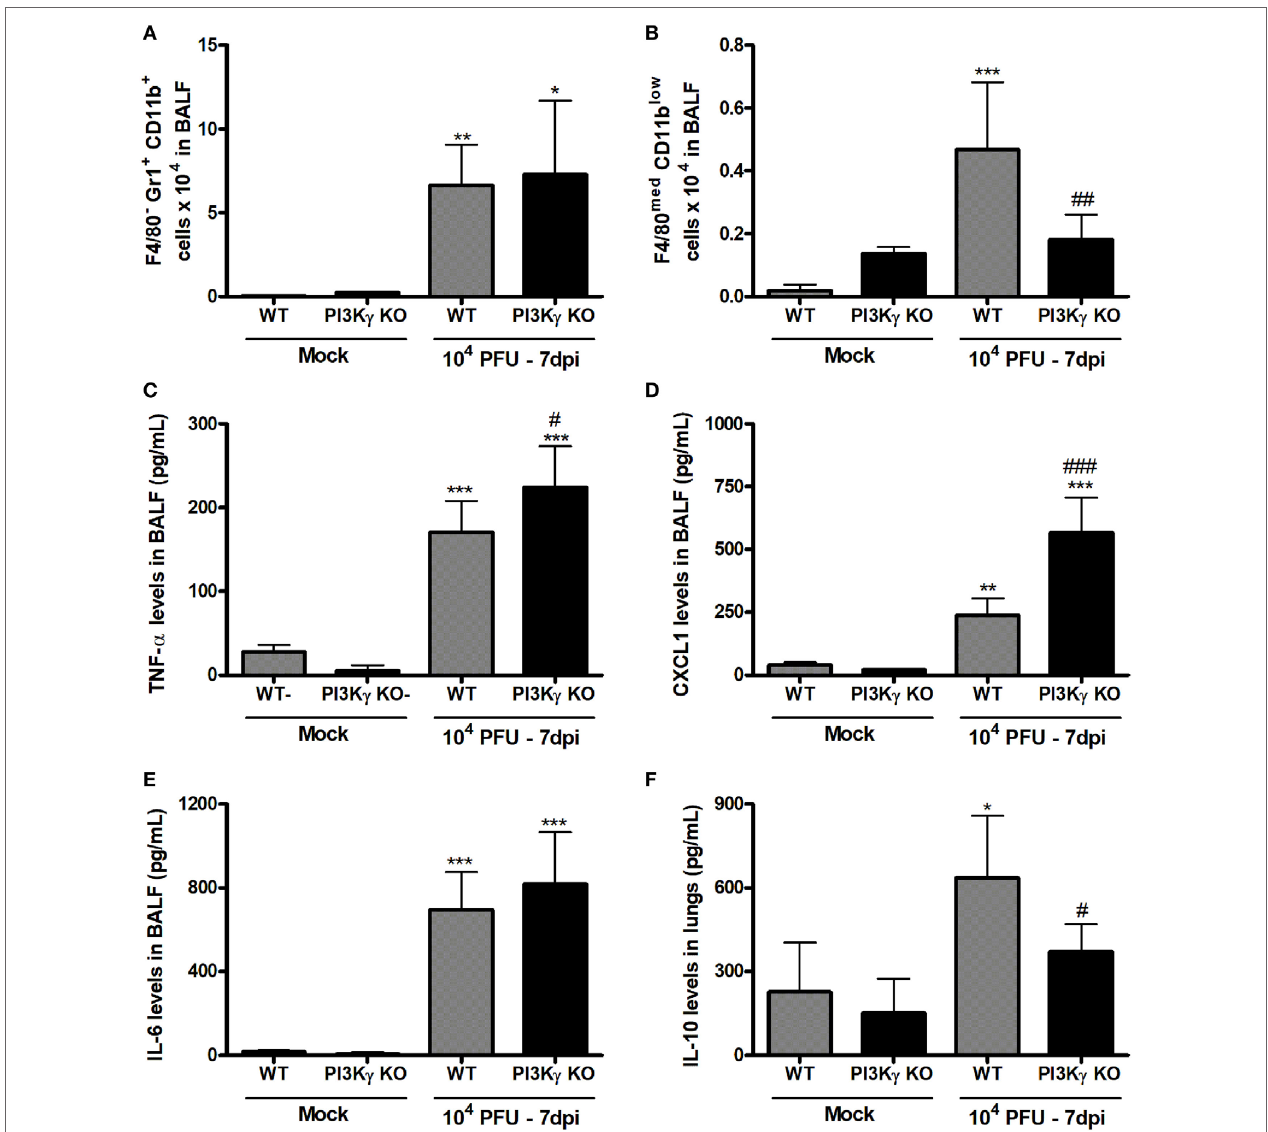
FigUre 7 | Unbalanced inflammatory pro-resolving responses in phosphatidyl inositol 3 kinase-gamma (PI3K γ ) knockout (KO) infected with influenza A virus. WT and PI3K γ KO mice were instilled with phosphate-buffered saline or WSN virus and euthanized at 7 days after infection (representative of two experiments showing n = 4–7 mice per group). FACS analysis in airways leukocytes showed (a) numbers of neutrophils (F4/80 − Gr1 + CD11b + ) and (B) resolving macrophages (F4/80 med CD11b low ). Levels of (c) TNF- α , (D) CXCL1, and (e) IL-6 in bronchoalveolar lavage fluid (BALF) and from (F) IL-10 in the lungs were assessed by ELISA. Results are presented as mean ± SD. * p < 0.05, ** p < 0.01, and *** p < 0.001, when compared with each Mock group; # p < 0.05, ## p < 0.01, and ### p < 0.001, comparing